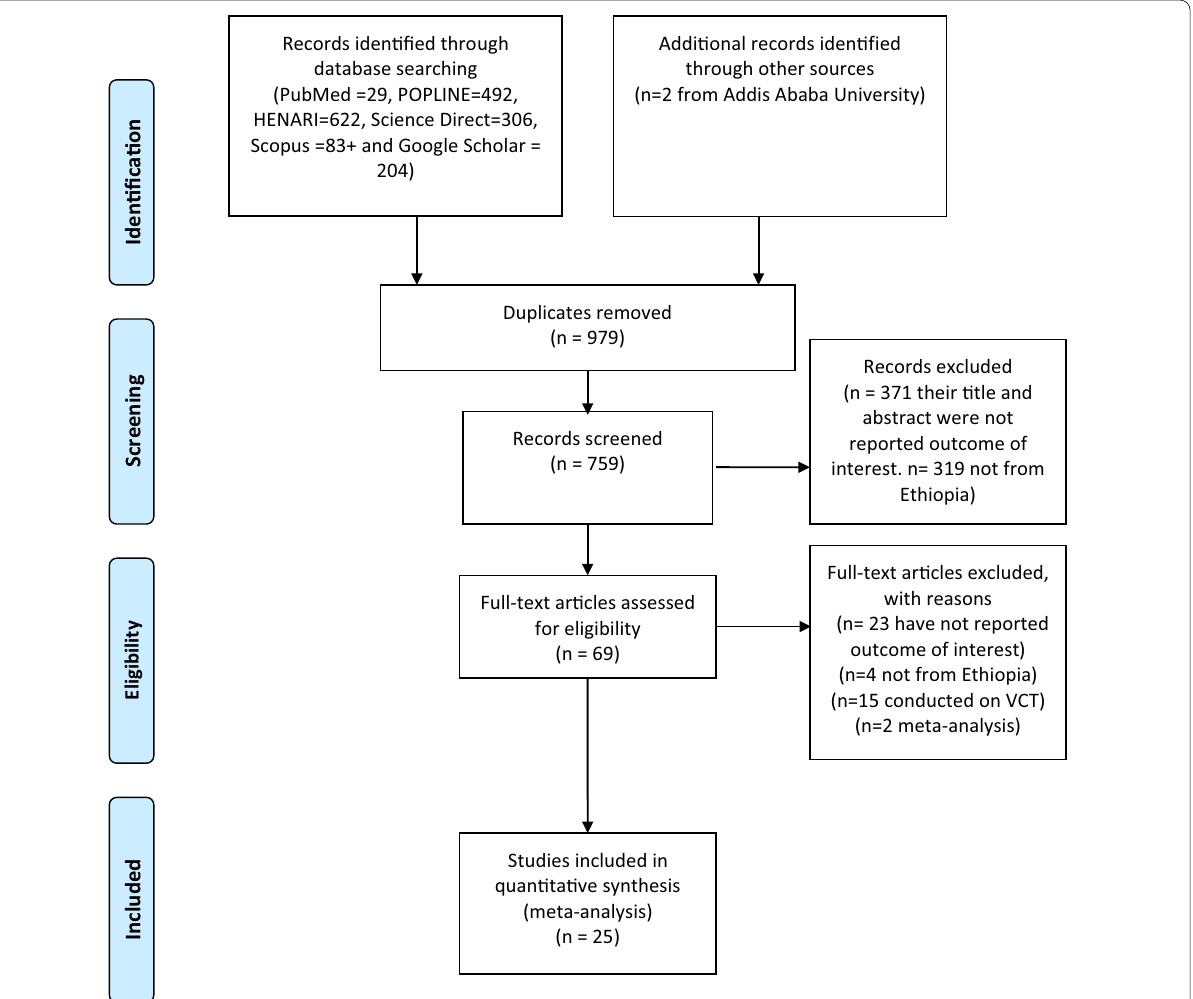
Fig. 1 Flow diagram of systemic review and meta-analysis conducted on utilization of PITC Ethiopia,